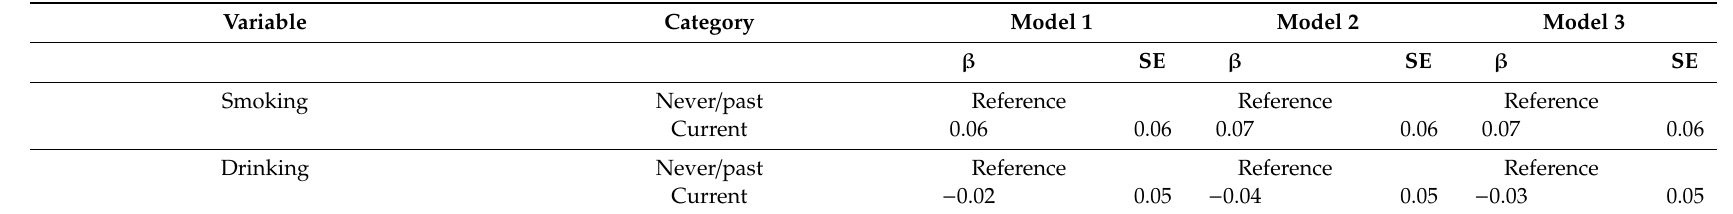
Table 3. The association between family caregiver burden and subjective well-being, multivariable linear regression analysis (women) Variable